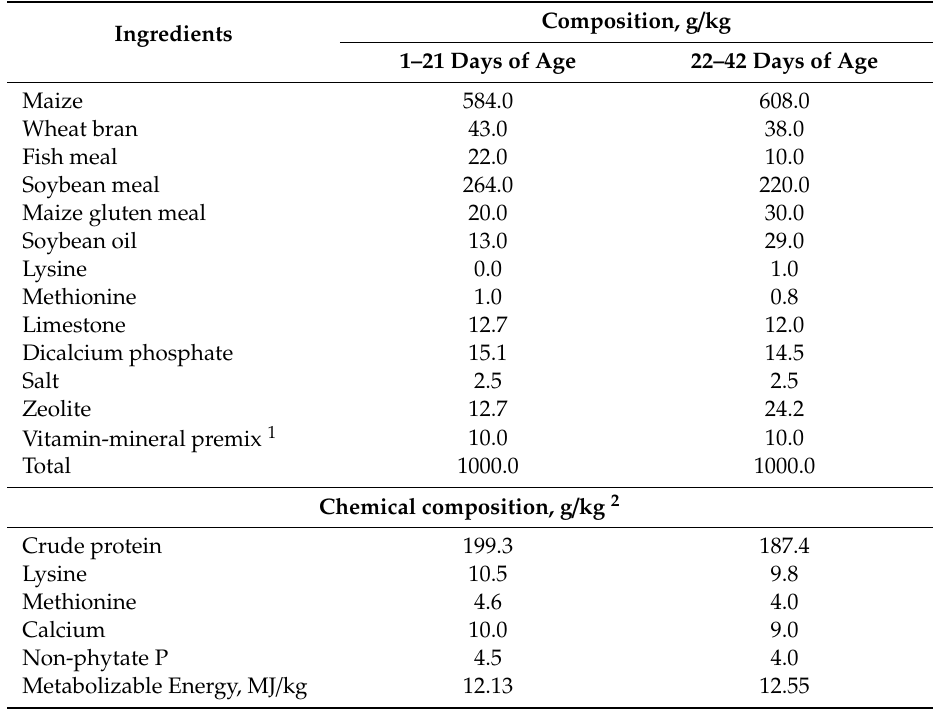
Table 1. Ingredient and composition of the basal diets for Chinese yellow-feathered broilers at 1–21 and 22–42 days of age (as fed-basis).